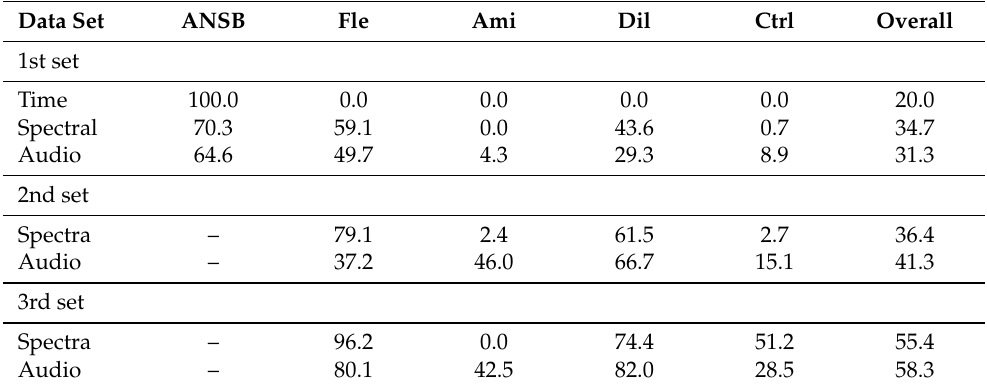
Table 1. Accuracy percentage of unsupervised learning autoencoders with several in-order training sets. ANSB is Autonomous Nervous System Blockade, Fle is Flecainide, Ami is Amiodarone, Dil is Diltiazem, and Ctrl is